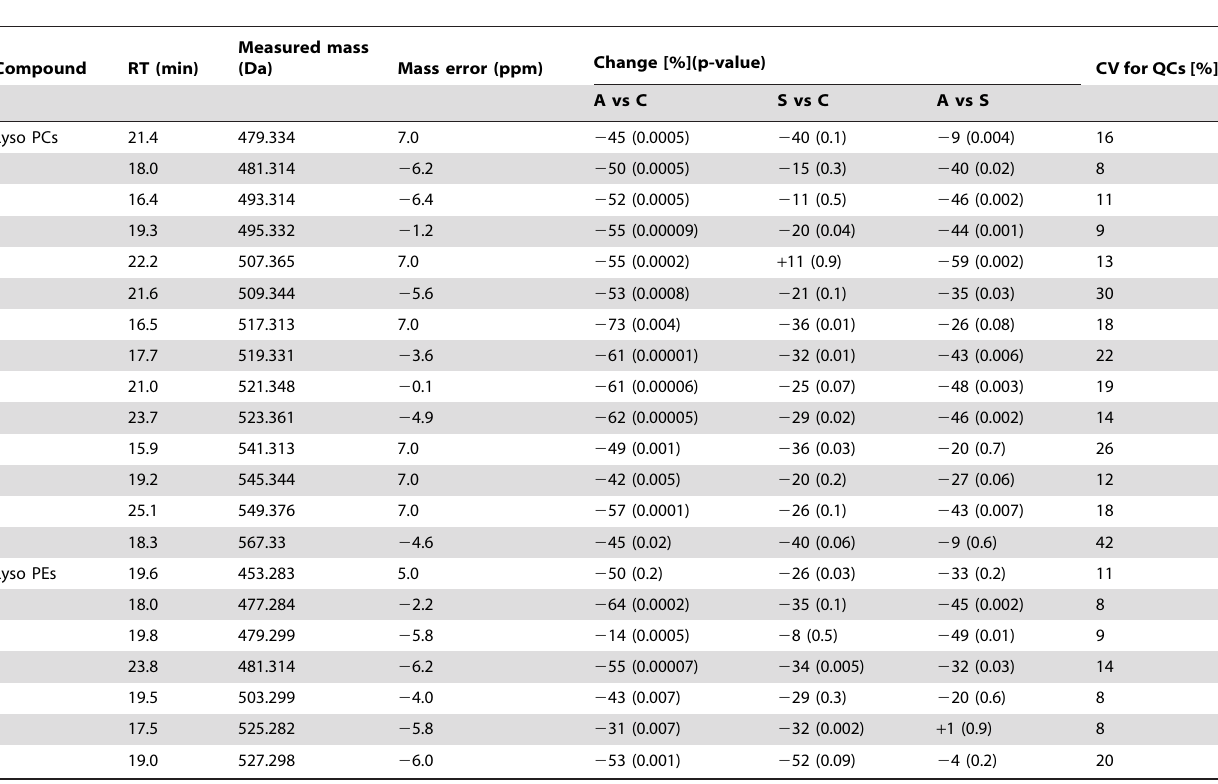
Table 4. Identification of lysophospholipids that were significantly differentiating plasma profiles of AAA patients from controls.